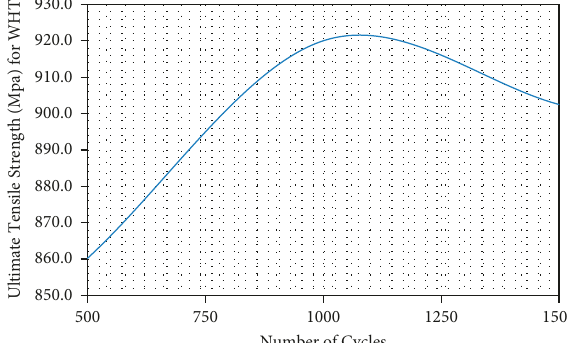
Figure 8: Ultimate tensile strength of WHT.